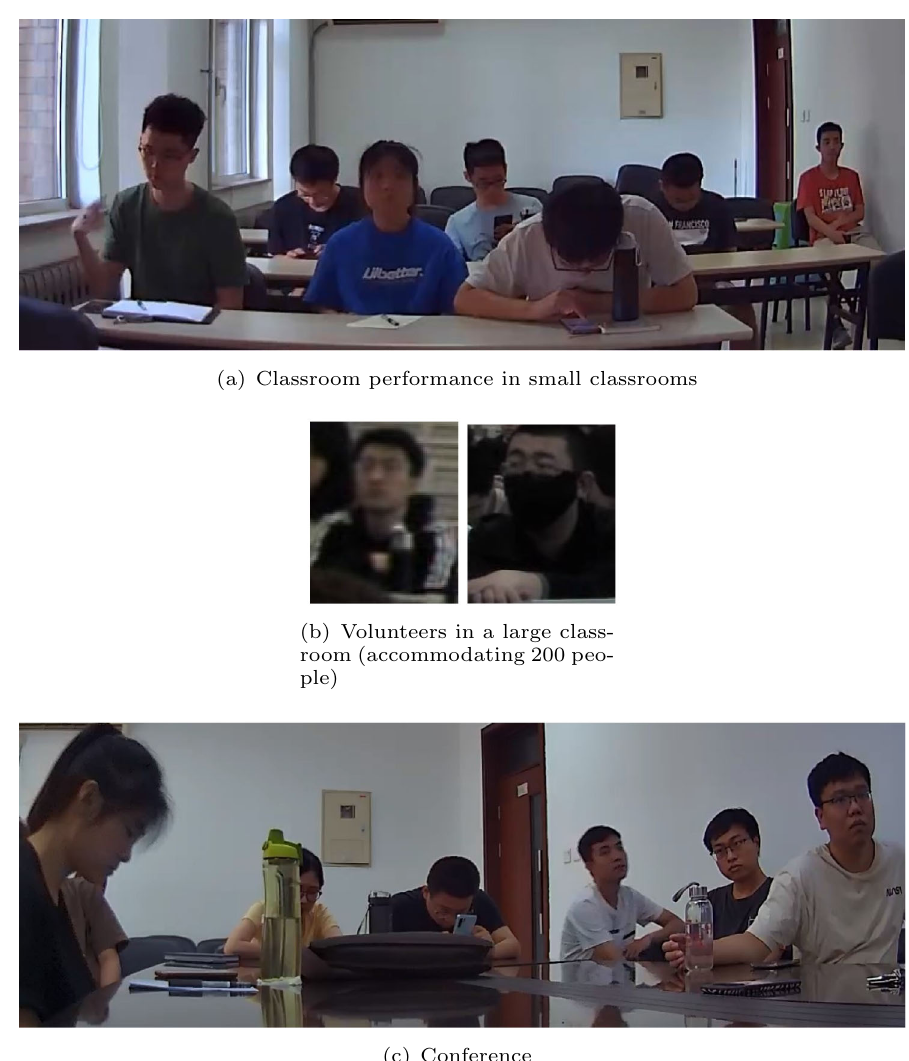
Fig. 4 Classroom performance